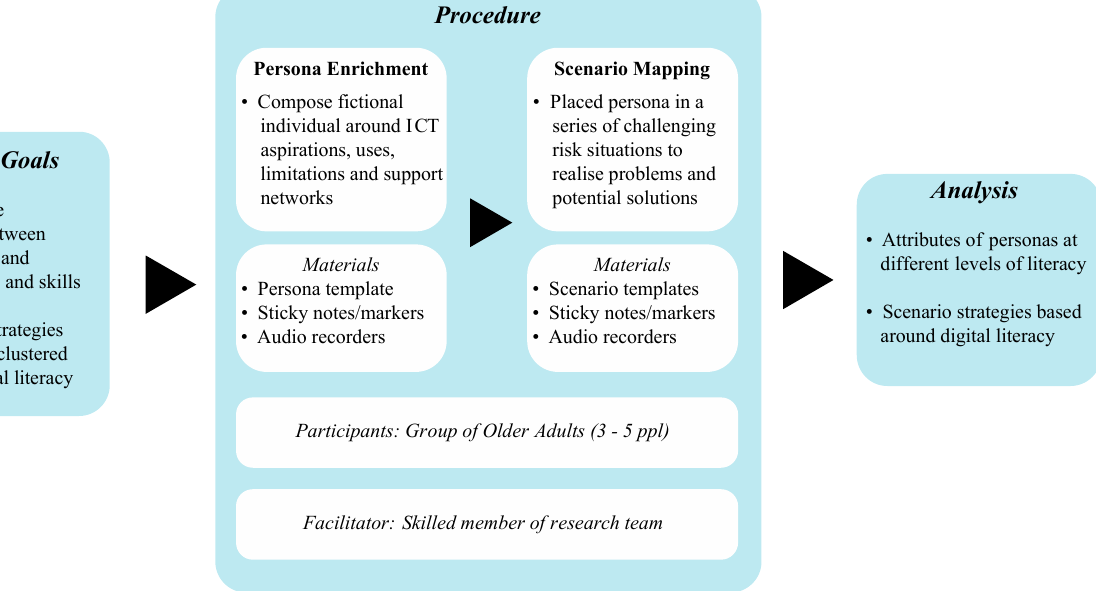
Figure 1. Workshop design.